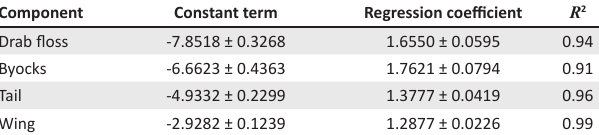
TABLE 3: Allometric coefficients relating the natural logarithms of the weighed feathers to the natural logarithms of the total feather weight. Component